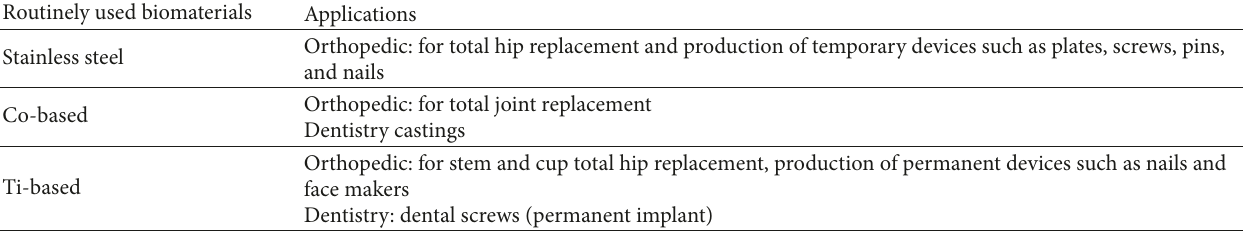
Table 1: Routinely used metallic biomaterials and their primary applications [23, 41, 42].